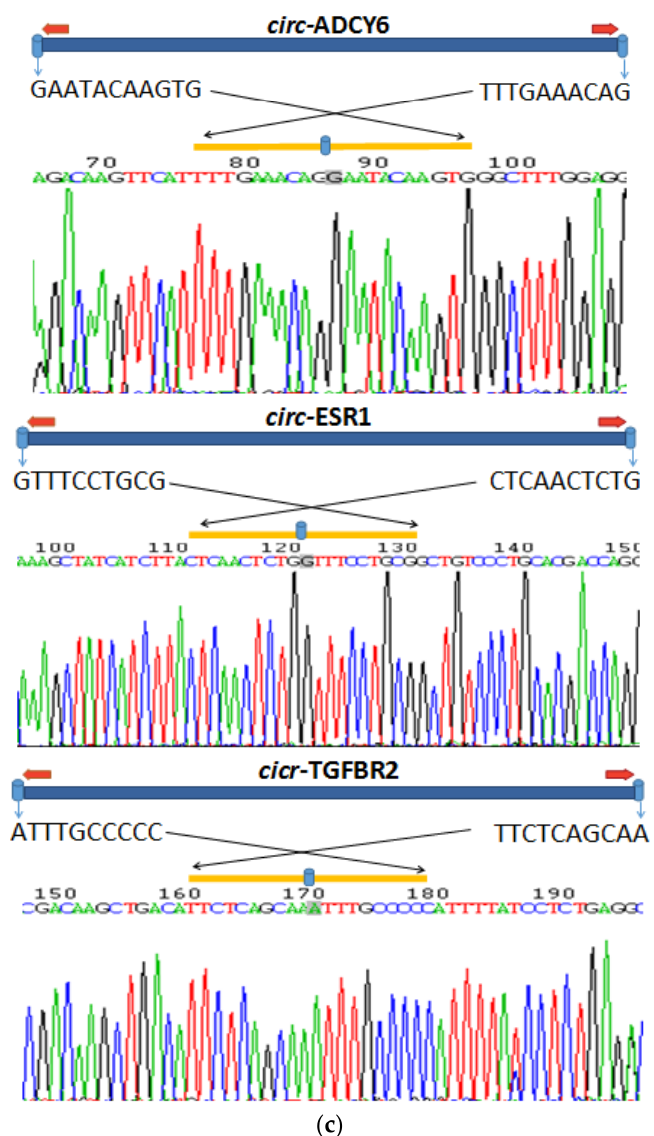
Figure 6. RNase R resistance assay. ( a ) Illustration of the annotated genomic region of circ-ADCY6 . The putative different RNA splicing forms and convergent (red ►◄ ) and divergent (blue ◄► ) primers were designed to amplify the linear and back-splicing products. ( b ) Total RNA from the brain with or without RNase R treatment was subjected to RT-PCR. Divergent and convergent primers were designed to amplify the back-splicing or linear products. ( c ) Representative examples of RT-PCR products sequenced to confirm circRNA junction sequences.